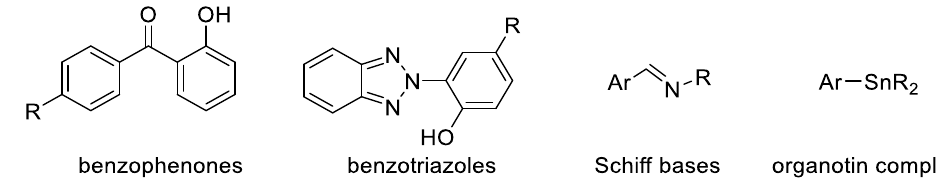
Figure 3. Structures of some common UV absorbers.